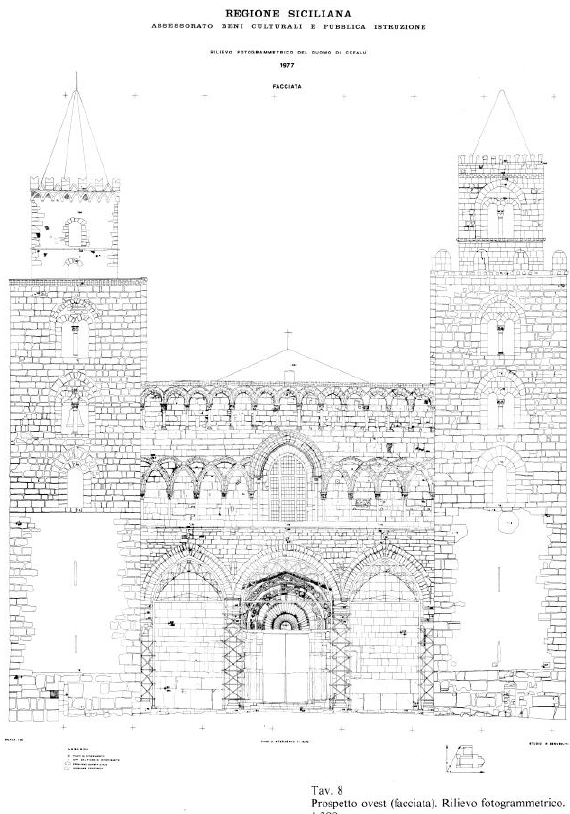
Figure 3. Photogrammetric restitution of ‘Duomo di Cefalù’ facade (Prescia,